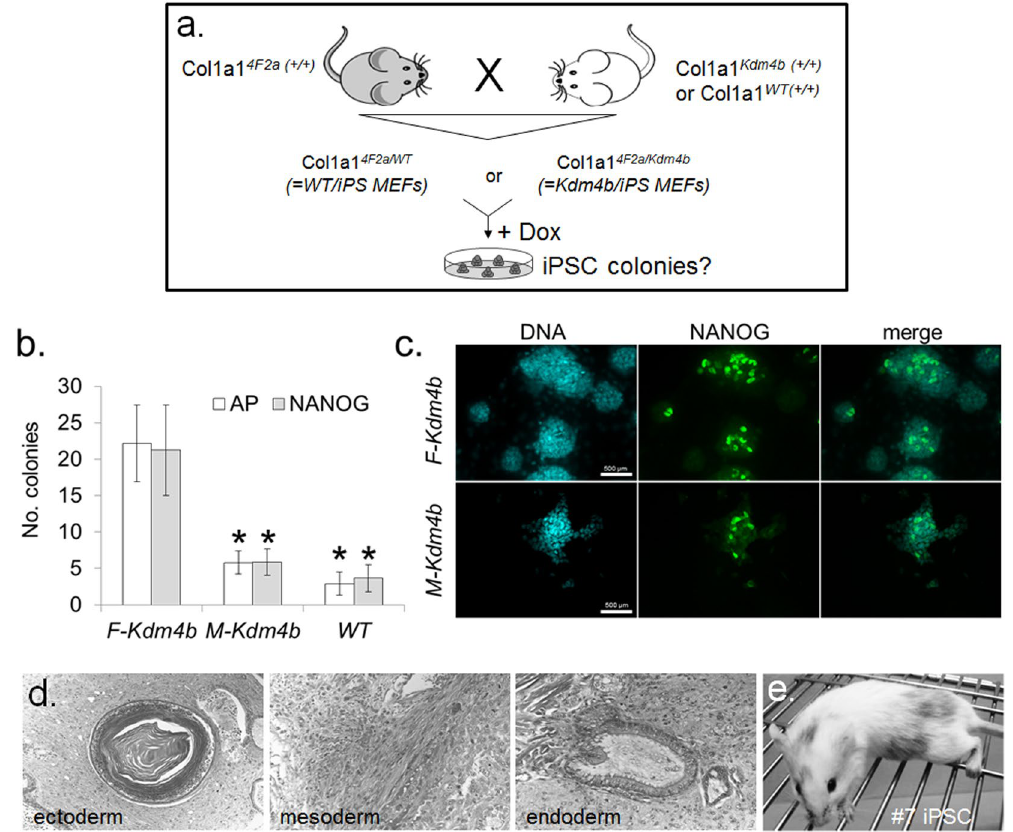
Figure 5. Derivation of iPSCs from reprogrammable Kdm4b and wild-type MEFs. ( a ) Breeding scheme to obtain reprogrammable MEFs for iPSC assay. ( b ) Formation of alkaline phosphatase (AP)- and NANOG- positive iPSC colonies from F-Kdm4b , M-Kdm4b and wild-type (WT) MEFs. Colony numbers ± SEM were counted following one week of Dox withdrawal after 21 days in culture; * F-Kdm4b differs from controls at P < 0.05 by two-tailed unpaired t-tests (n = 6 biological replicates). ( c ) Immunofluorescence against NANOG in primary colonies on D28, after one week of Dox withdrawal. ( d ) Histological sections of intramuscular teratomas from Kdm4b iPSC line #1, showing differentiation into all three germ layer derivatives. ( e ) Following blastocyst injection, iPSC line #7 contributes to coat-color